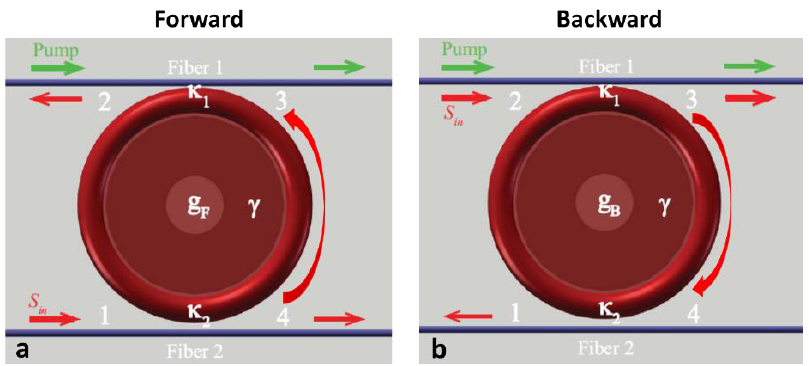
Figure 1. An active WGM microtoroid resonator coupled to two tapered optical fibers for the experimental realizations of on-chip asymmetric light transmission. The signal laser is tuned to be resonant with the cavity resonant frequency ( 𝜔 ). The pump field is used to 0 produce an effective gain ( 𝑔 in the forward propagation and 𝑔 in the backward) for the 𝐹 𝐵 signal wave through optically pumping doped erbium-doped ions.  1 and  2 represent the coupling strengths of toroid-fiber 1 and toroid-fiber 2, respectively. 𝛾 is the cavity intrinsic decay rate. Light transports are examined by measuring transmittance spectra in the forward ( a ) and backward ( b ) propagation configurations. 𝑠 stands for the amplitude of 𝑖𝑛 the input signal